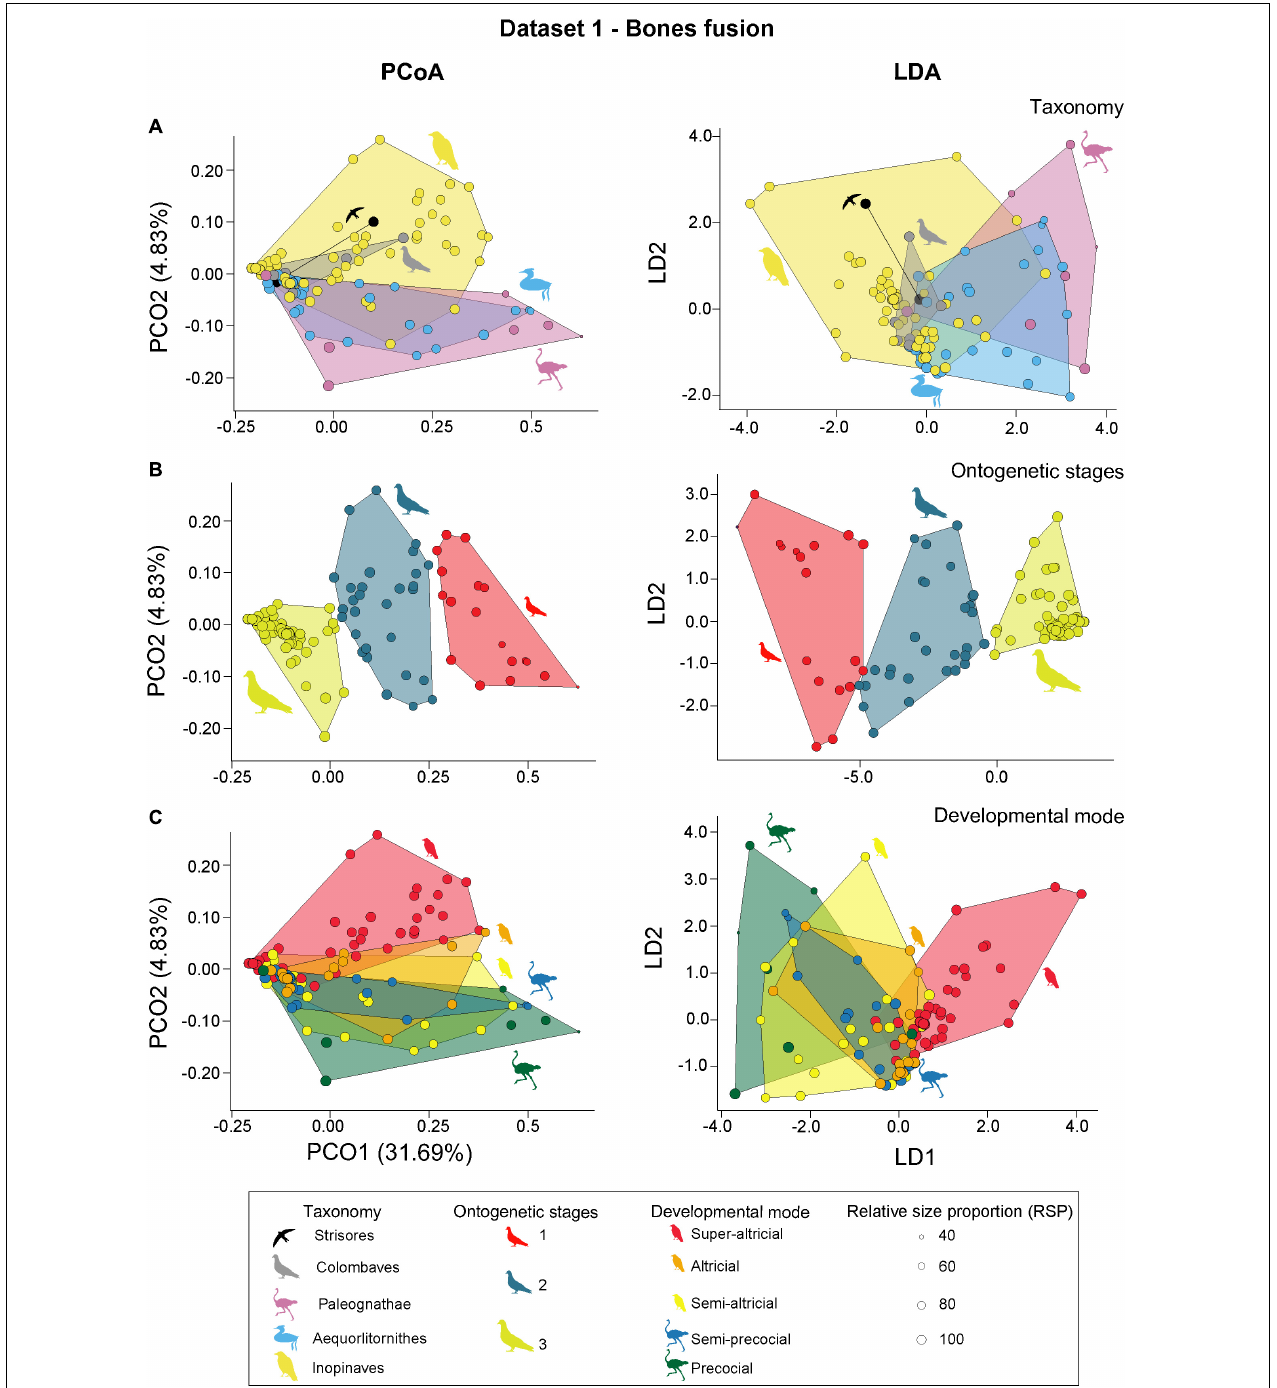
FIGURE 3 | PCoA (principal coordinate analysis) and LDA (linear discriminant analysis) results of dataset 1. (A) PCoA and LDA results showing the taxonomic morphospaces. (B) PCoA and LDA results showing the ontogenetic morphospaces. (C) PCoA and LDA results showing the morphospaces of the developmental modes. All silhouettes are taken from